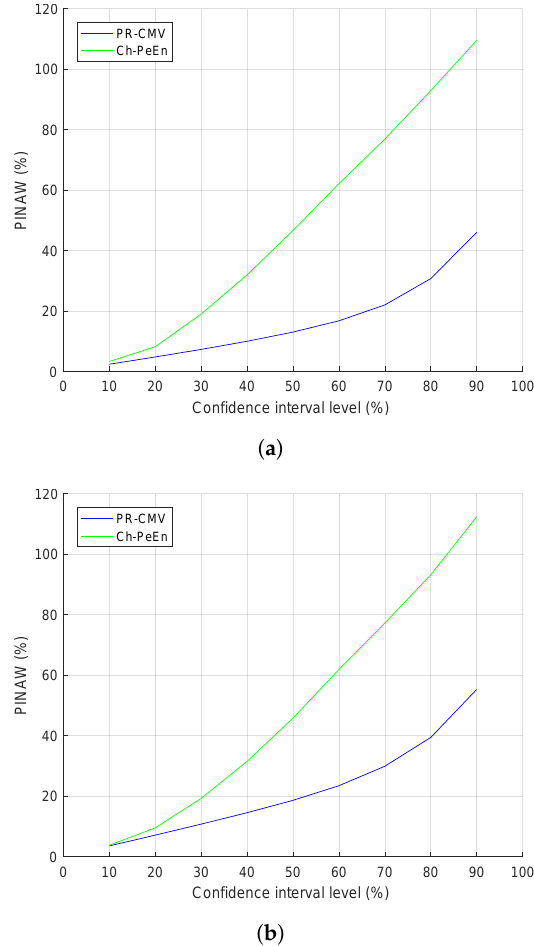
Figure 4. Sharpness of the probabilistic forecast models CH-PeEn and Pr-CMV for the two sites, Carpentras ( a ) and Signes ( b